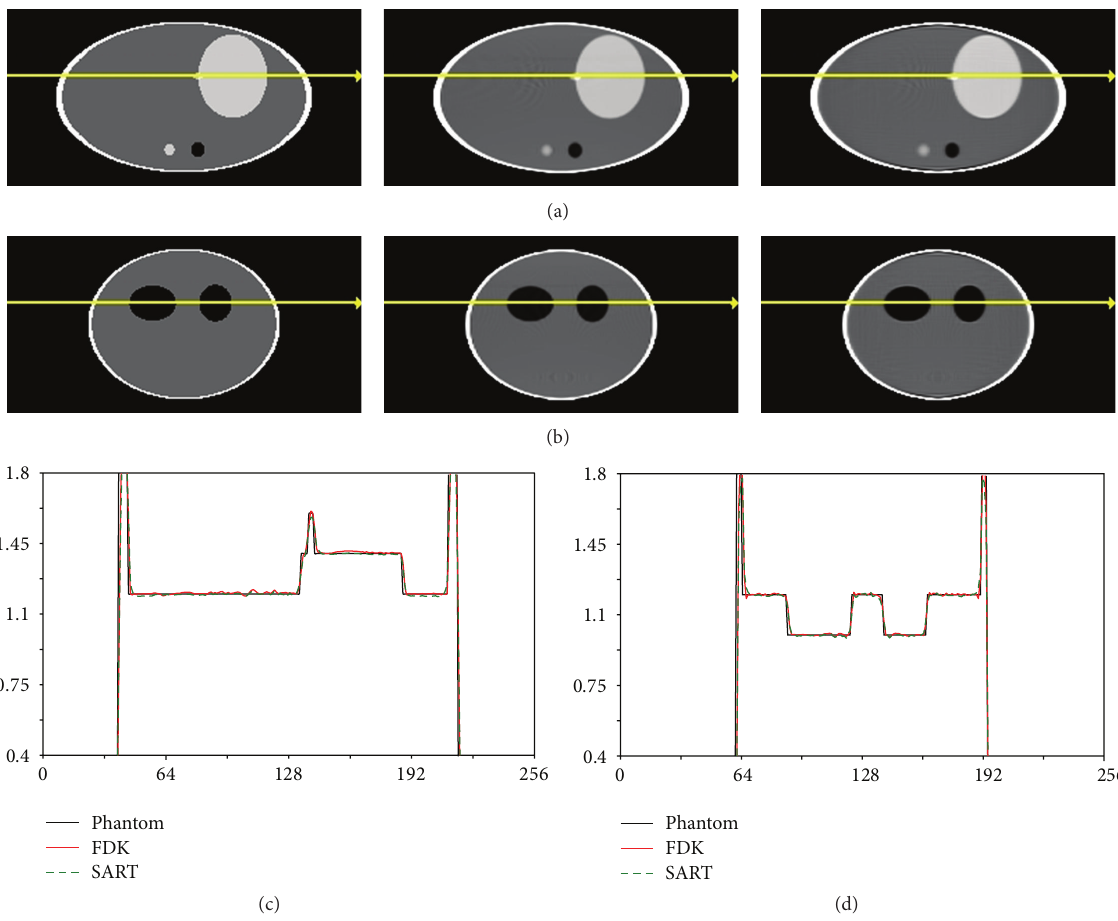
Figure6:ReconstructionofnoiselessShepp-Logandata.(a)Sagittaland(b)coronalviewsofreconstructedimages.(c)Sagittaland(d)coronal profiles of reconstructed images. In (a) and (b), from left to right are phantom, FDK reconstruction, and SART reconstruction images. For both the coronal and sagittal SART reconstructions, overshoot artifacts can be observed at the top and bottom edges of the phantom.